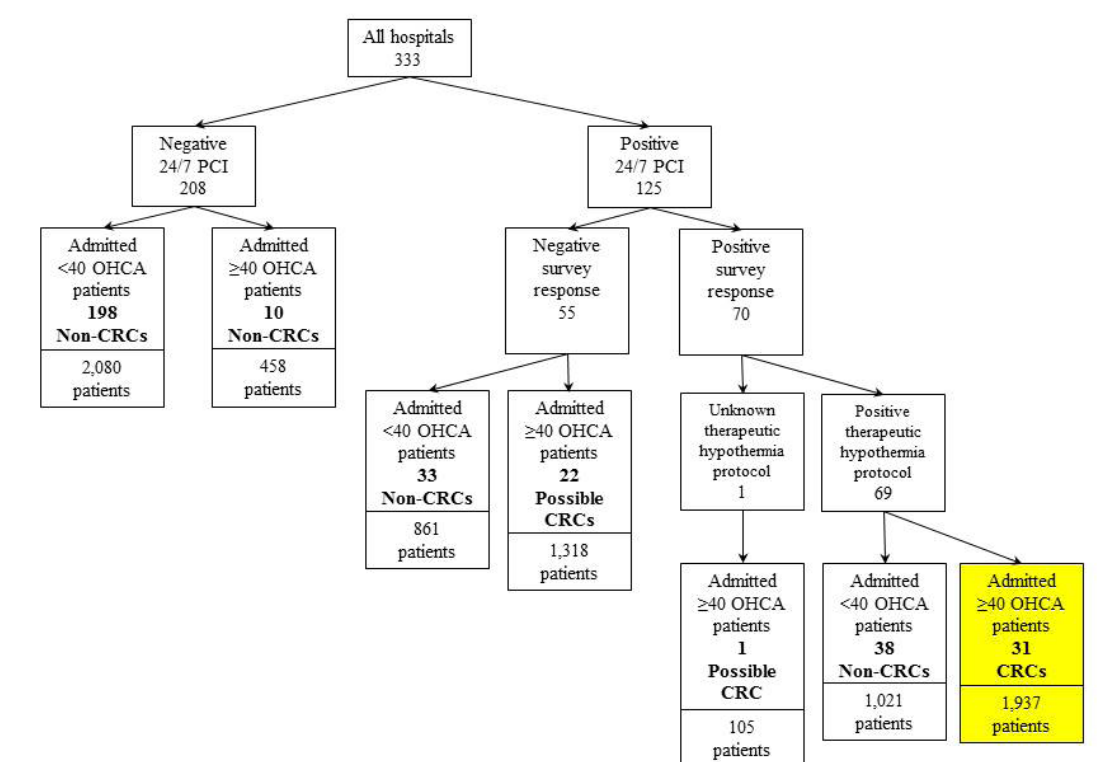
Figure 1 . Classification of hospitals.